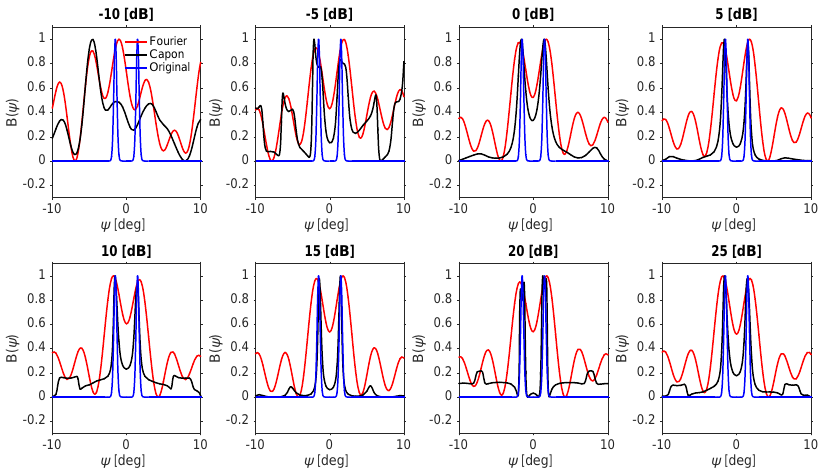
Figure 3. Numerical simulations of the Fourier and Capon methods under different SNR conditions. The simulated brightness function is described by two Gaussian functions centered at ± 1.5 ◦ and an angular width of 0.2 ◦ .